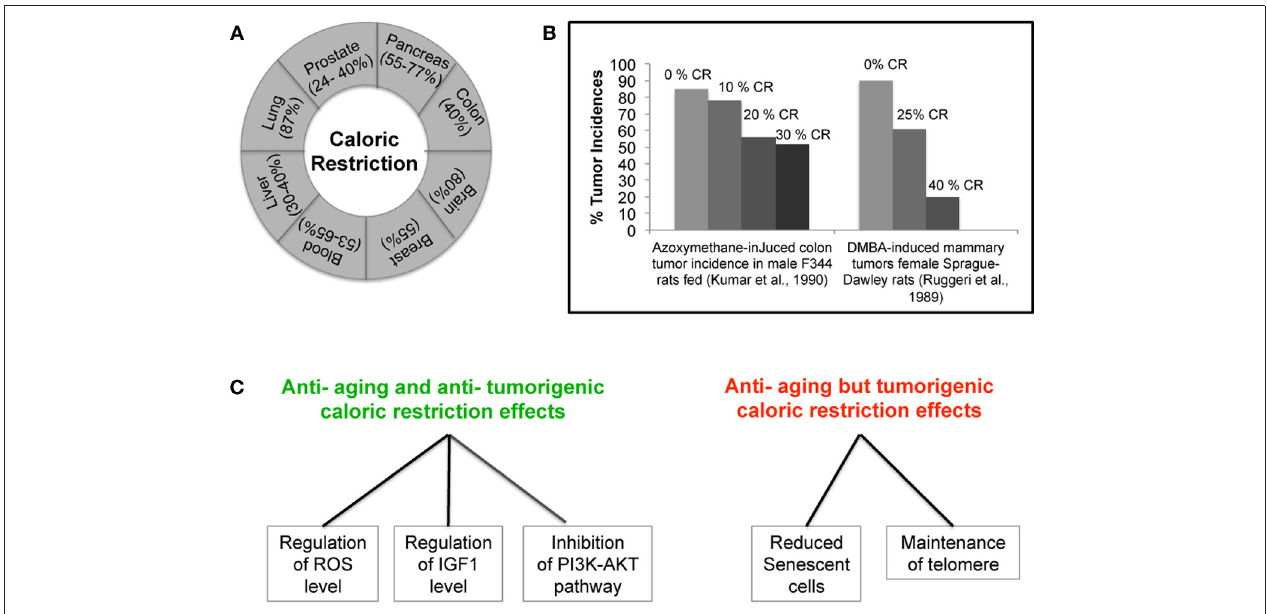
FIGURE 1 | Caloric Restriction (CR) and Cancer. (A) CR effectively inhibits various kinds of cancer in animal models. (B) Correlation between decrease in the incidence of tumor and severity of CR. (C) Demonstration of parallel and opposing effects of CR on cancer and aging. The ability of CR to